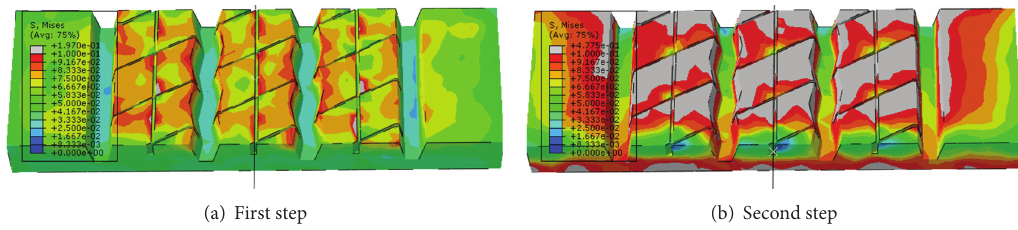
Figure 14: Distribution of von mises stress for tread block under the conditions: 𝛼 = 12 ∘ and 𝛽 = 14 ∘ .